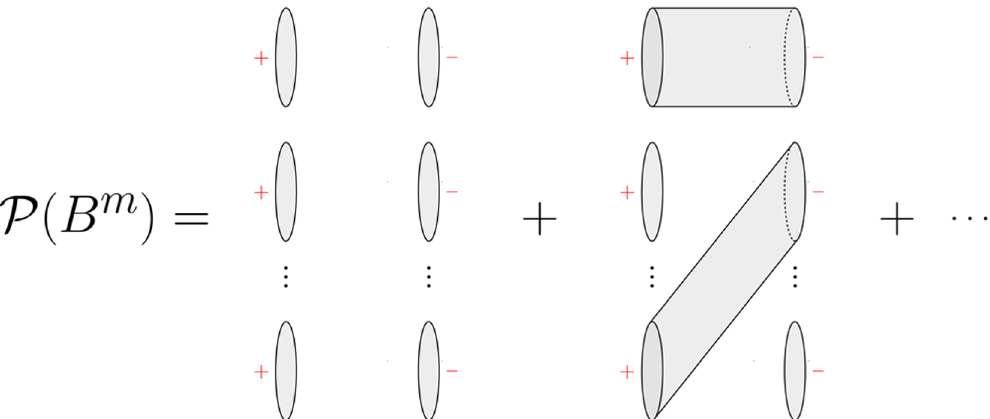
Figure 8 . Computation of P ( B m ) . Wormholes connect a + boundary to a −